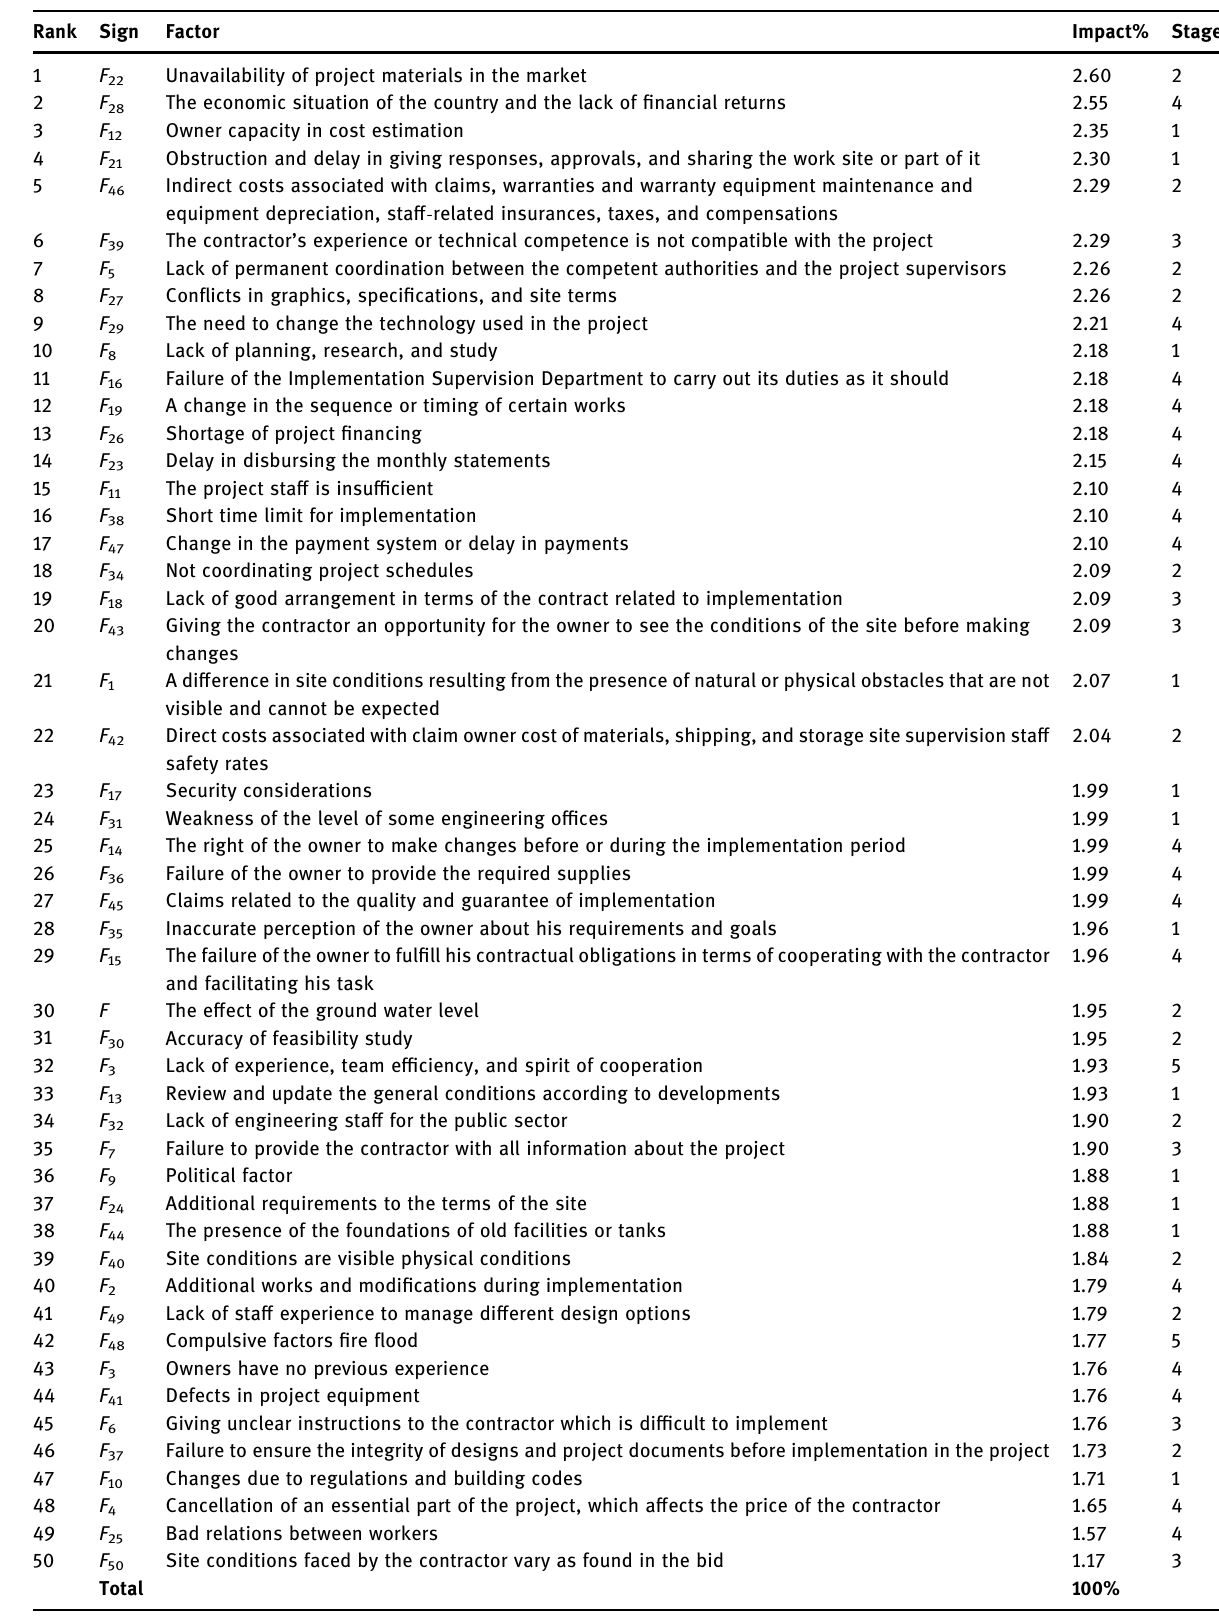
Table 3: Global factors are ranked according to their impact and stage Rank